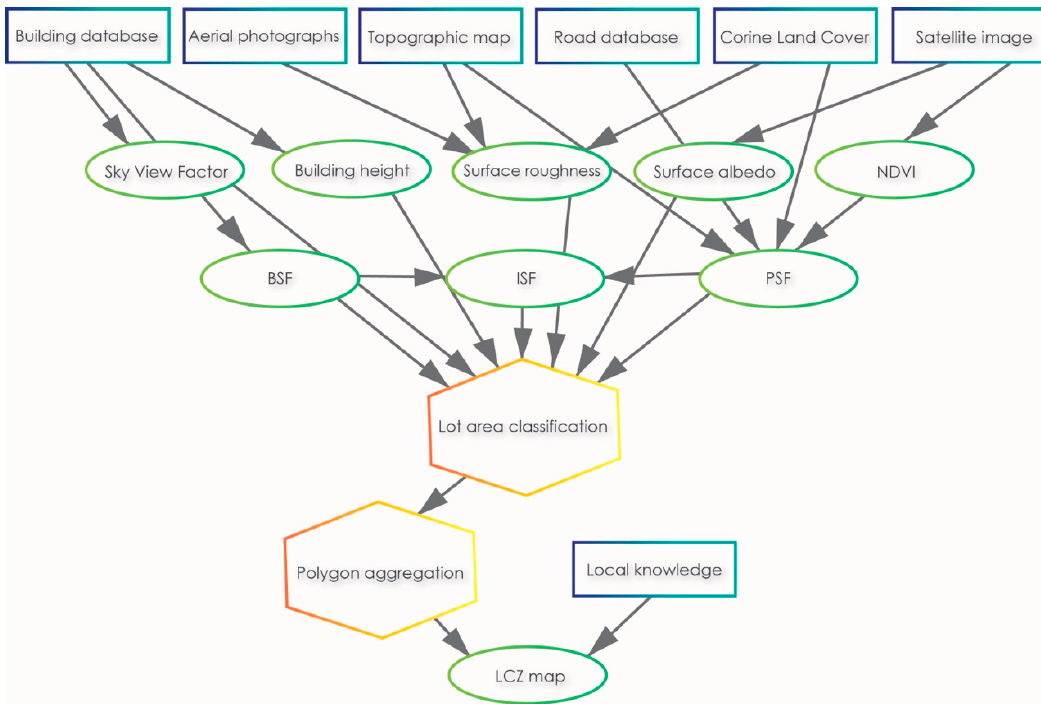
Figure 7. Flow-chart of the GIS-based method, after Lelovics et al. [51]. Source: Unger et al. [81] (published by Hungarian Geogrophical Bulletin , 2014 , 63 , 29–41, doi:1-0.1520L/hungeobull.53.1.3 f). Note: NDVI–normalized difference vegetation index; BSF-building surface fraction; ISF-impervious surface fraction; PSF-previous surface fraction.